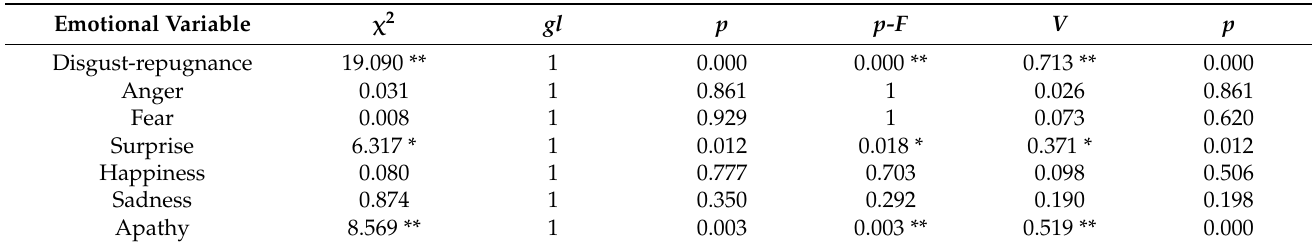
Table 5. Relation and degree of association between the emotional variables and sex.